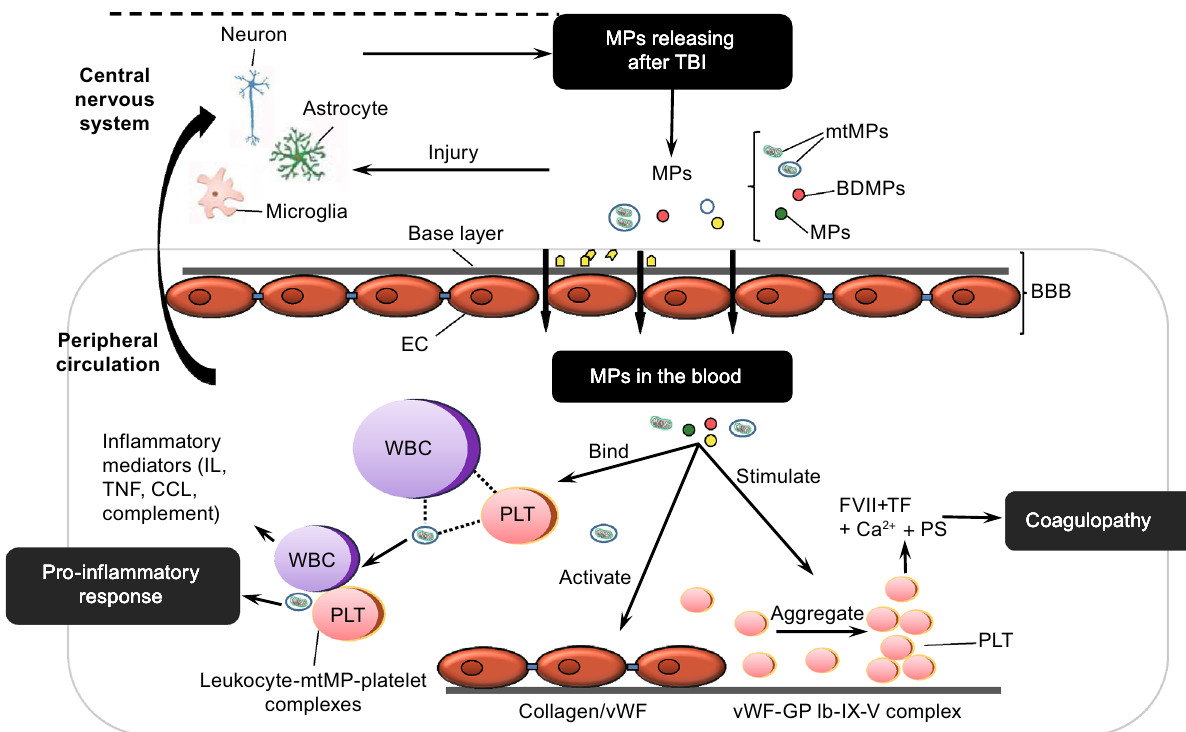
Figure 2. A schematic illustration of MPs-mediated intercellular communication in TBI. Upon injury, neurons, microglia cells, and astrocytes release MPs into peripheral blood through disrupted BBB. These BDMPs activate platelets and promote platelet adhesion to the activated endothelium and exposed subendothelium at sites of vascular injury through multiple ligand-receptor interactions. Activated platelets also provide a PS-rich surface on which tissue factor forms a complex with coagulation factor VIIa to initiate the extrinsic pathway of coagulation. MPs interact with WBCs to promote in